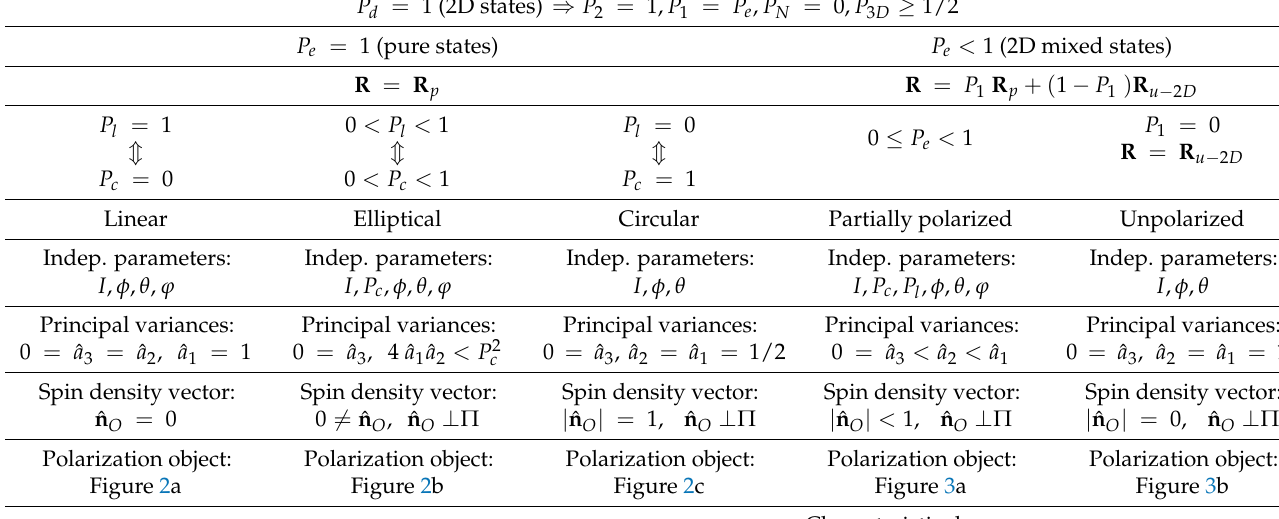
Figure 3. ( a ) Polarization object of a 2D mixed state